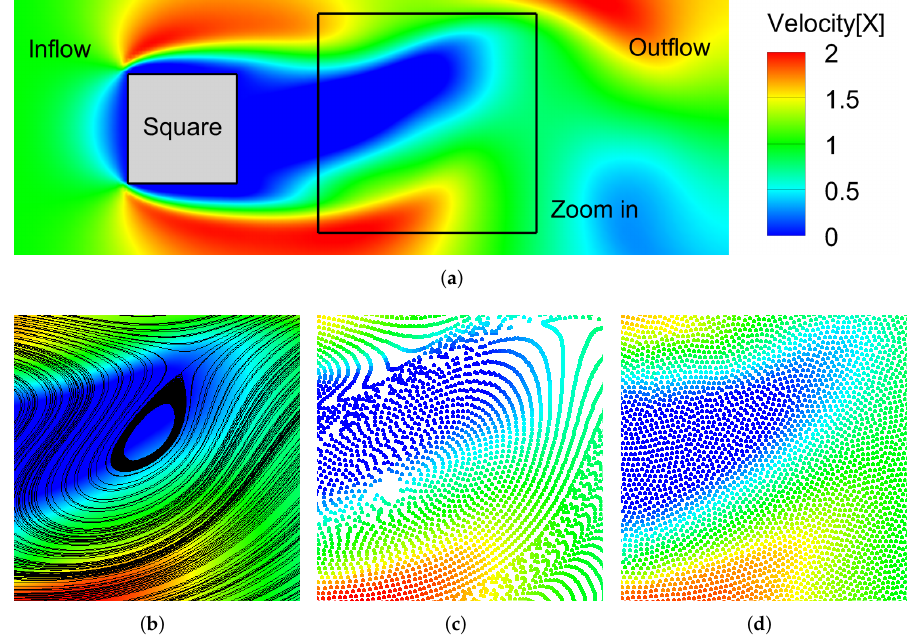
Figure 9. A uniform incoming flow crossing a square. The numerical results of panel ( a , b ) are obtained using an FV solver, while that of panel ( c , d ) are simulated via an SPH solver without and with PST, respectively. ( a ) FV result of the velocity field in the x -axis direction (Unit: m/s). ( b ) Streamlines via an FV solver. ( c ) SPH result without PST. ( d ) SPH result with